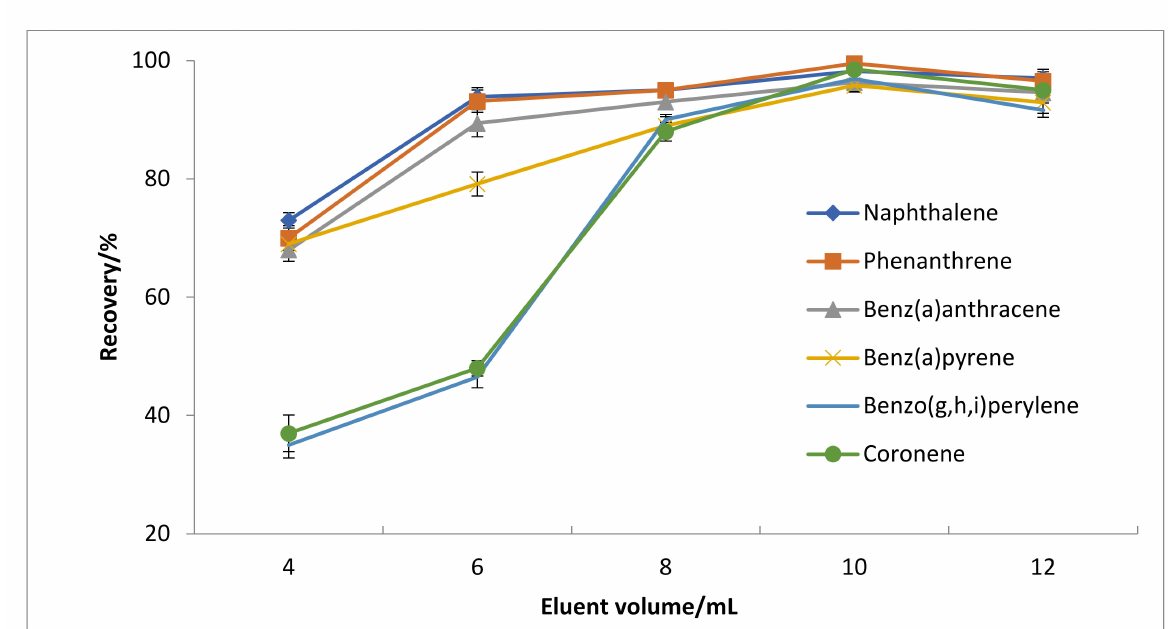
Figure 4. Effects of elution volume on recoveries of PAHs using solid-phase extraction.